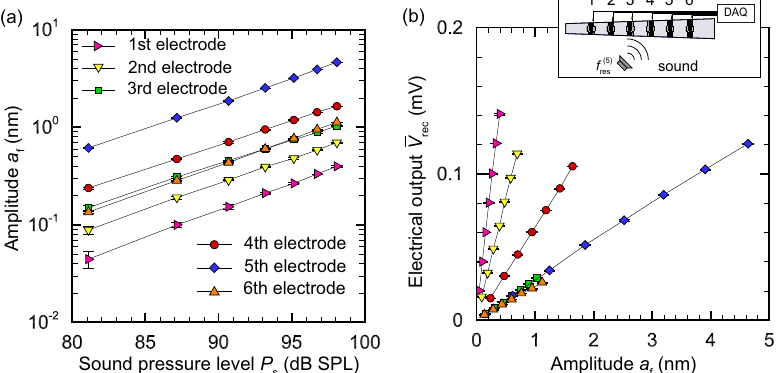
Figure 9. ( a ) Relationship between amplitude a f at x ( i ) ( i = 1, 2, · · · , 6) and sound pressure level P s ( 5 ) = 4.56 kHz. The membrane vibration increased with the sound pressure level applied for f s = f res to the artificial cochlear epithelium; ( b ) Relationship between electrical output ¯ V ( 5 ) = 4.56 kHz. Amplitude a and amplitude a f at x ( i ) for f s = f res the recognition electrodes had a linear